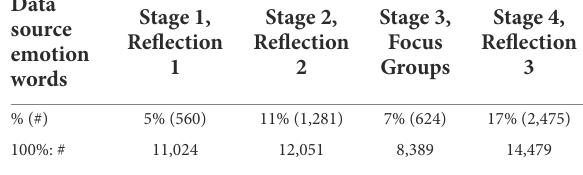
TABLE 3 Percentage of emotion words in each stage of the ML- adoption process. Data